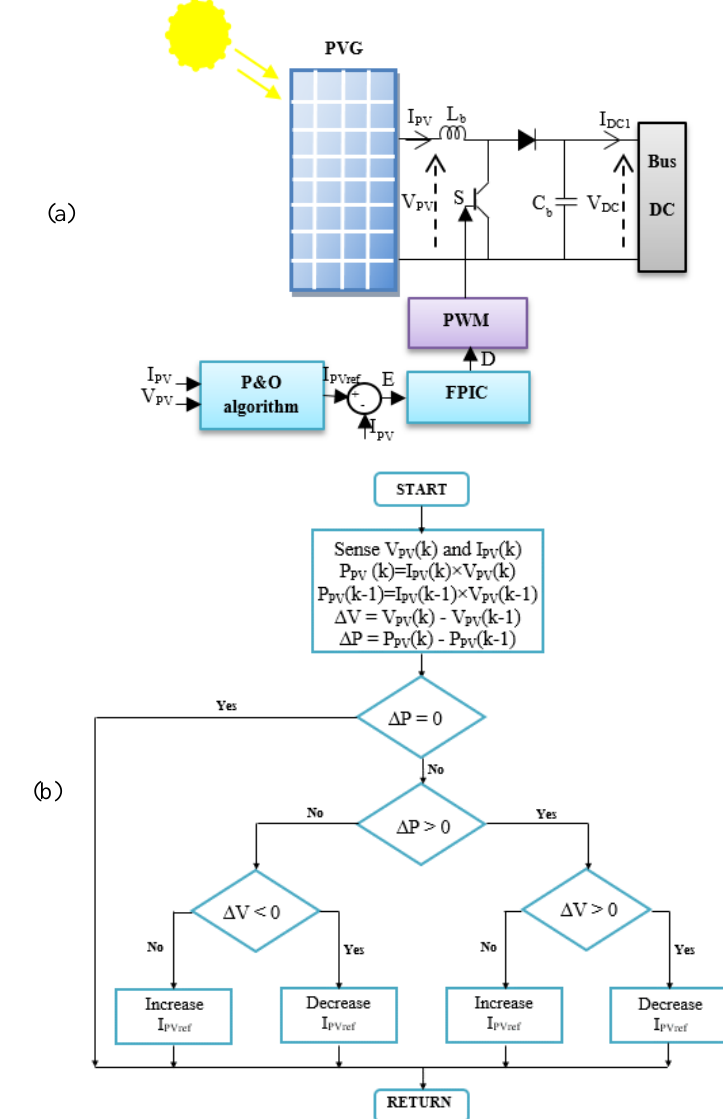
Figure 7. (a) Novel MPPT control for PVS; (b) P&O algorithm